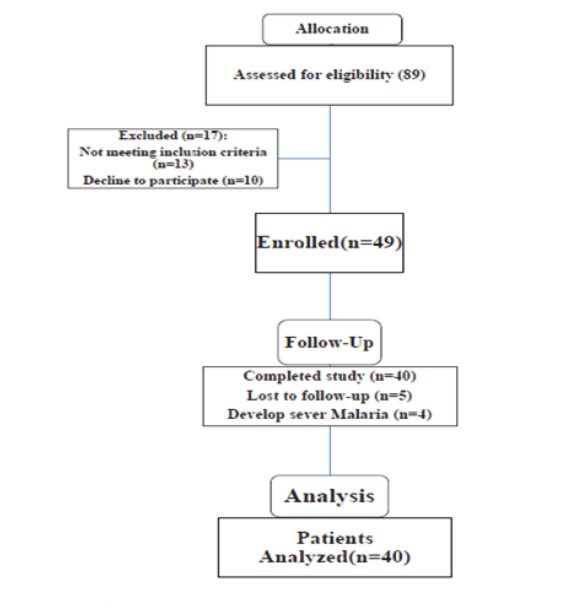
Figure 1: Participant flowchart.